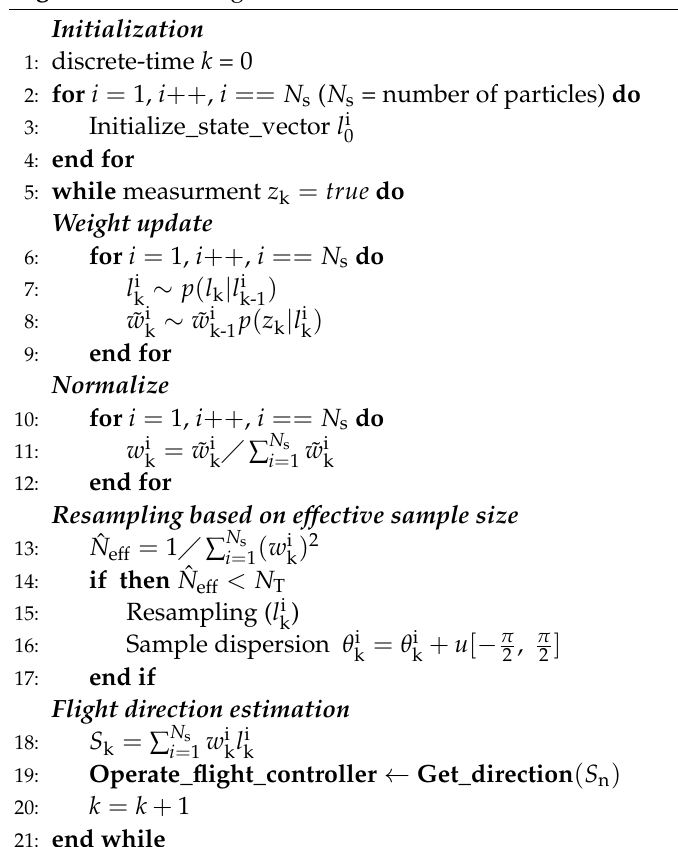
Algorithm 1 Guiding direction